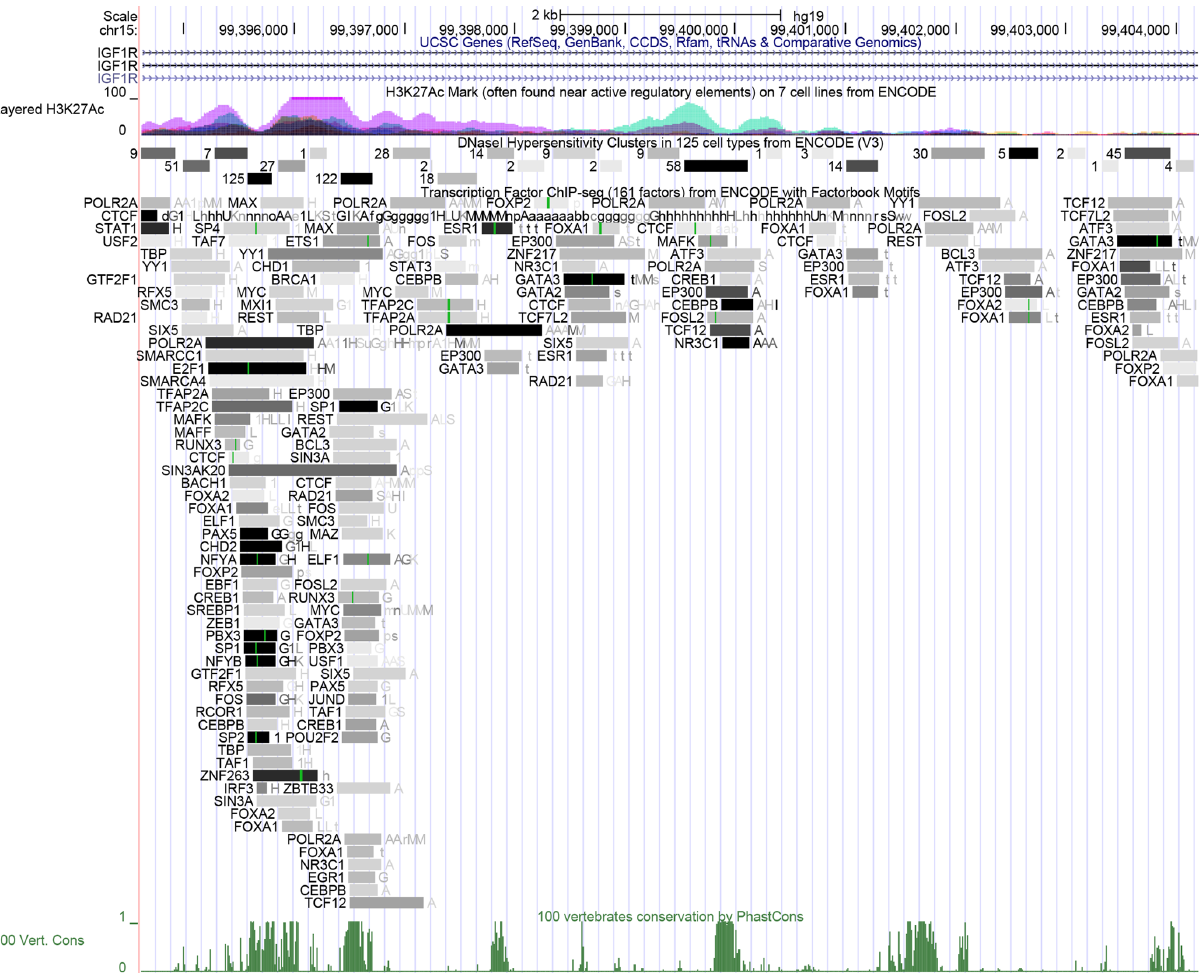
Figure 4. Bioinformatics analysis of IGF1R CNV. The peak means histone acetylation above this figure. The rectangle with a number or a letter means DNase I hypersensitive sites or sequence-specific TFs, respectively, and the darker the color, the more likely the combination is. The other peak means similarity between the sequence of IGF1R CNV in cattle and the whole-genome sequence in humans at the bottom of this